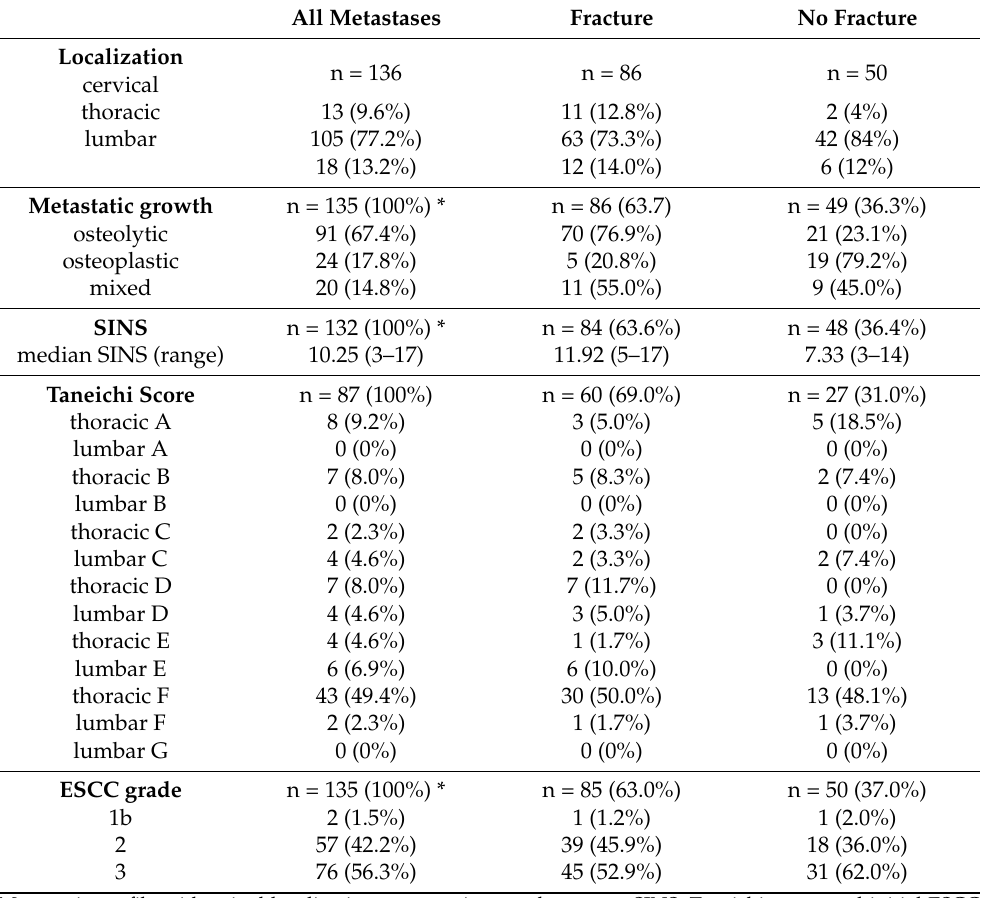
Table 3. Metastatic